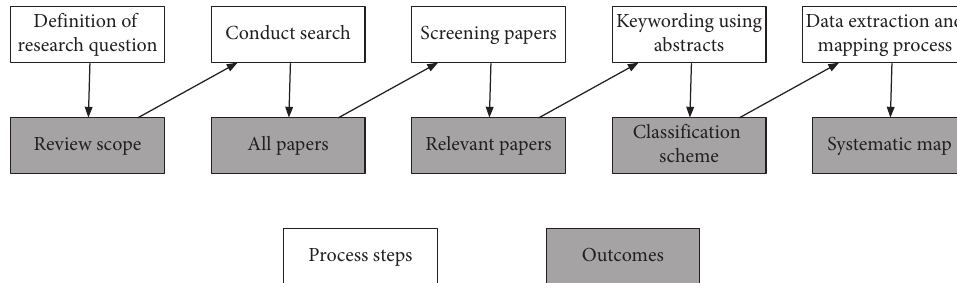
Figure 2: The systematic mapping study.